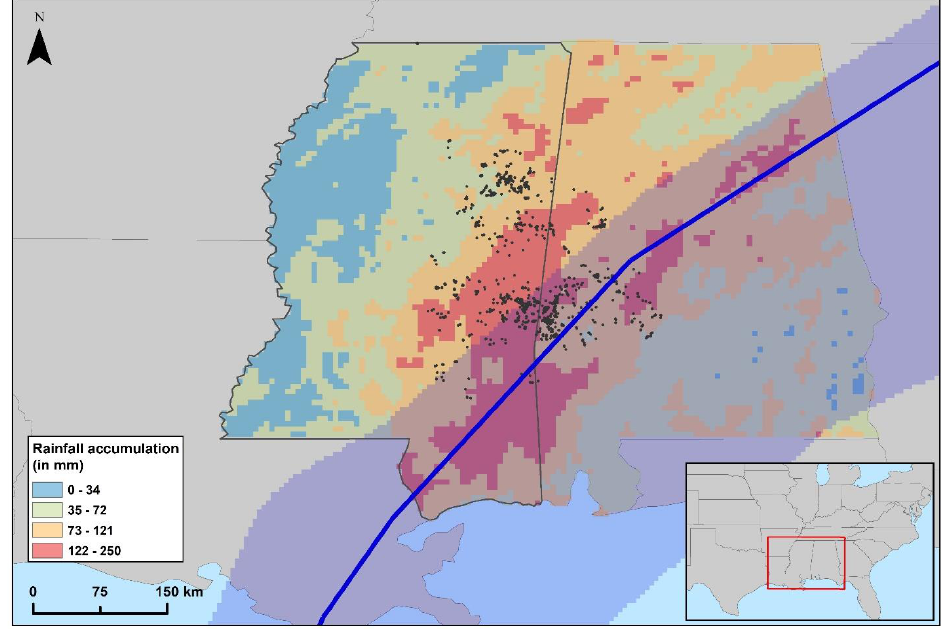
Figure 1. Rainfall accumulation from Hurricane Zeta between 24–29 October 2020. Black dots = vultures’ GPS fixes. Blue line and shadow correspond to Hurricane Zeta observed track and wind swaths, respectively.